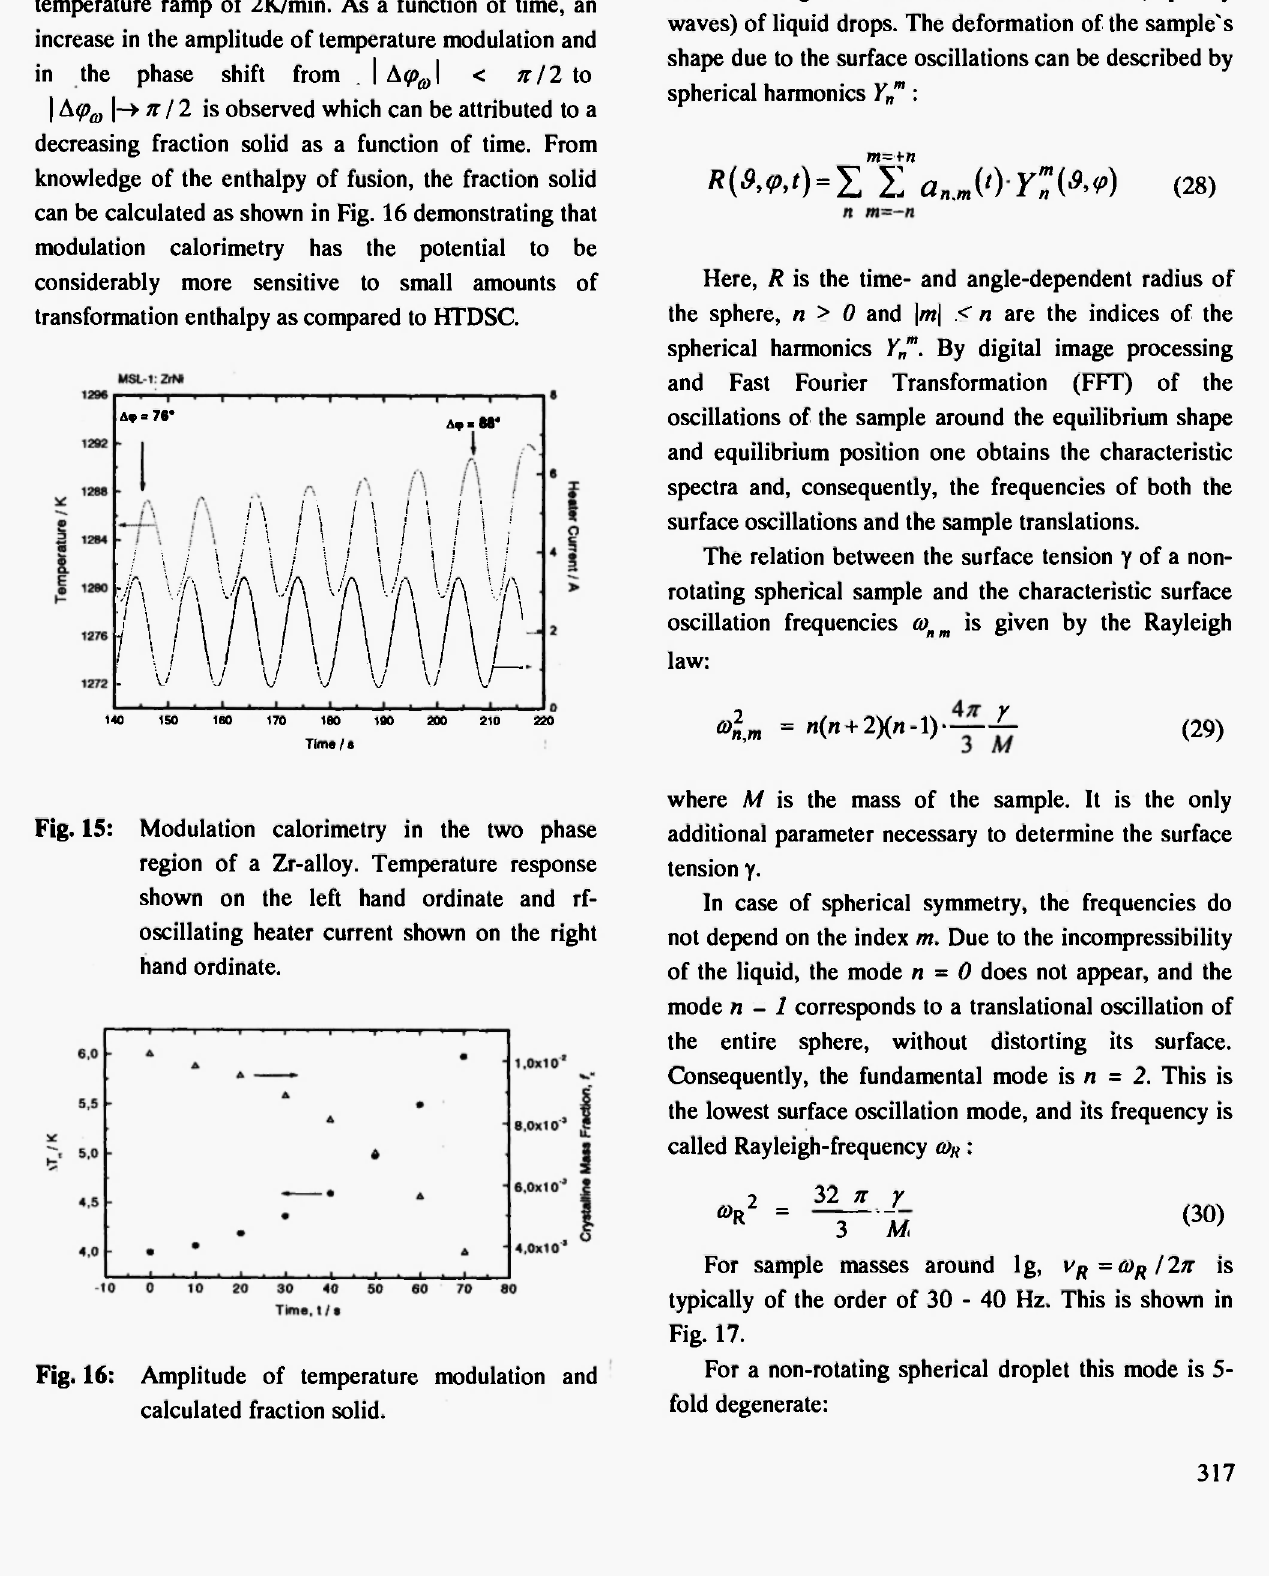
For sample masses around lg, ν Fig. 17. For a non-rotating spherical droplet this mode is 5- fold degenerate: